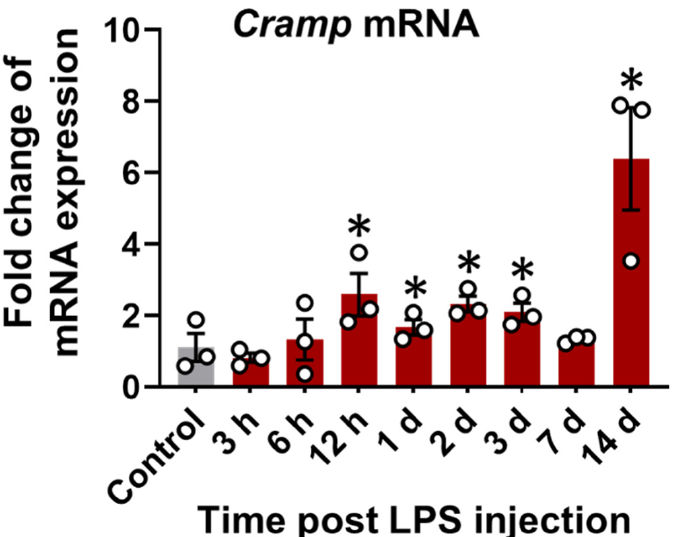
Figure 3. Cramp mRNA expression in LPS (i.p.)-injected mice. The Cramp mRNA level was deter- mined in the brain of LPS (i.p.)-injected mice at different time points. Data are mean ± SEM; n = 3; * p < 0.05 versus control. One-way ANOVA with Tukey’s post hoc test. n.s., not significant.